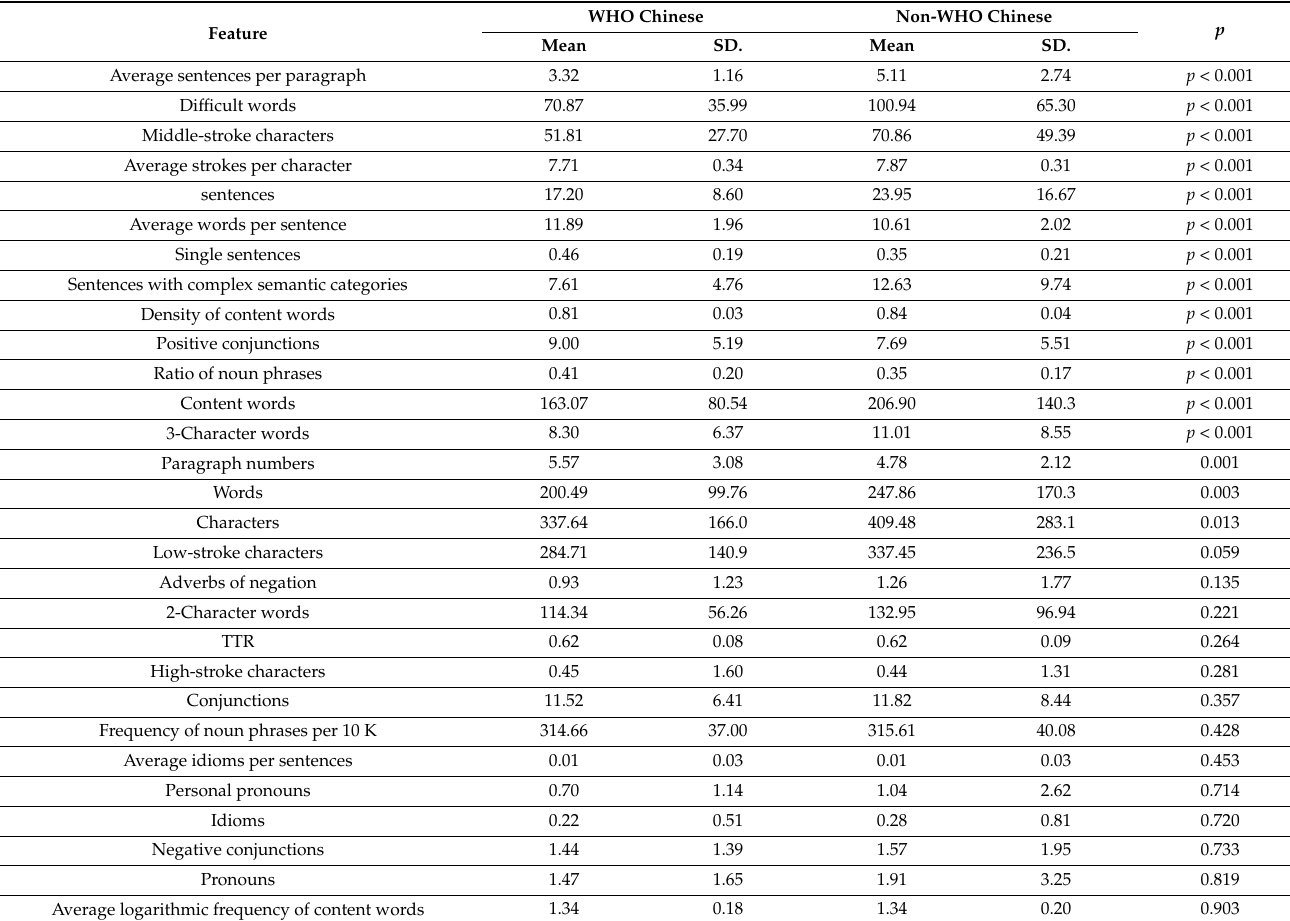
Table 1. Mann Whitney U